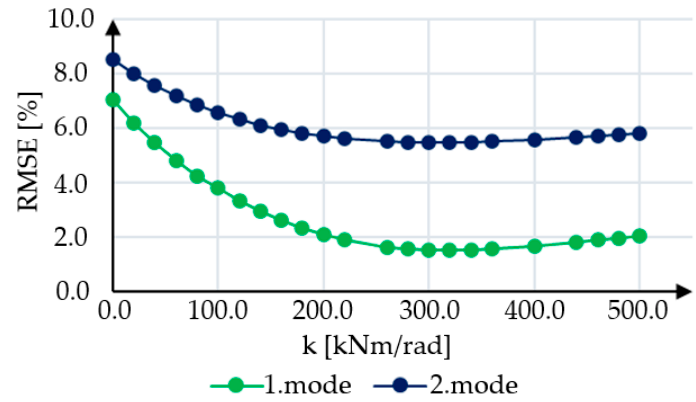
Figure 12. The values of the RMSE for the observed mode shapes and different spring stiffness values. ) and the relative error between